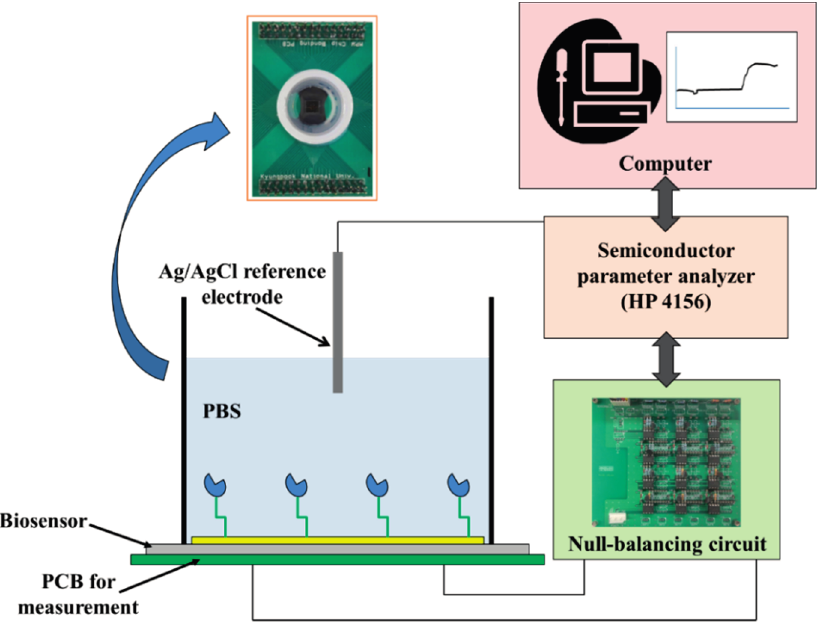
Figure 2. Measurement setup with the fabricated sensor chip packaged on a designed printed circuit